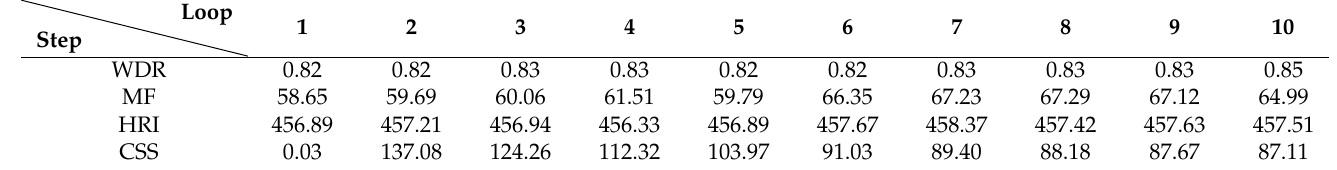
Table 2. Running time of different processing steps of the proposed method at different loops under the first WBI (similar running time can be obtained under the other two WBIs). The unit is ms.